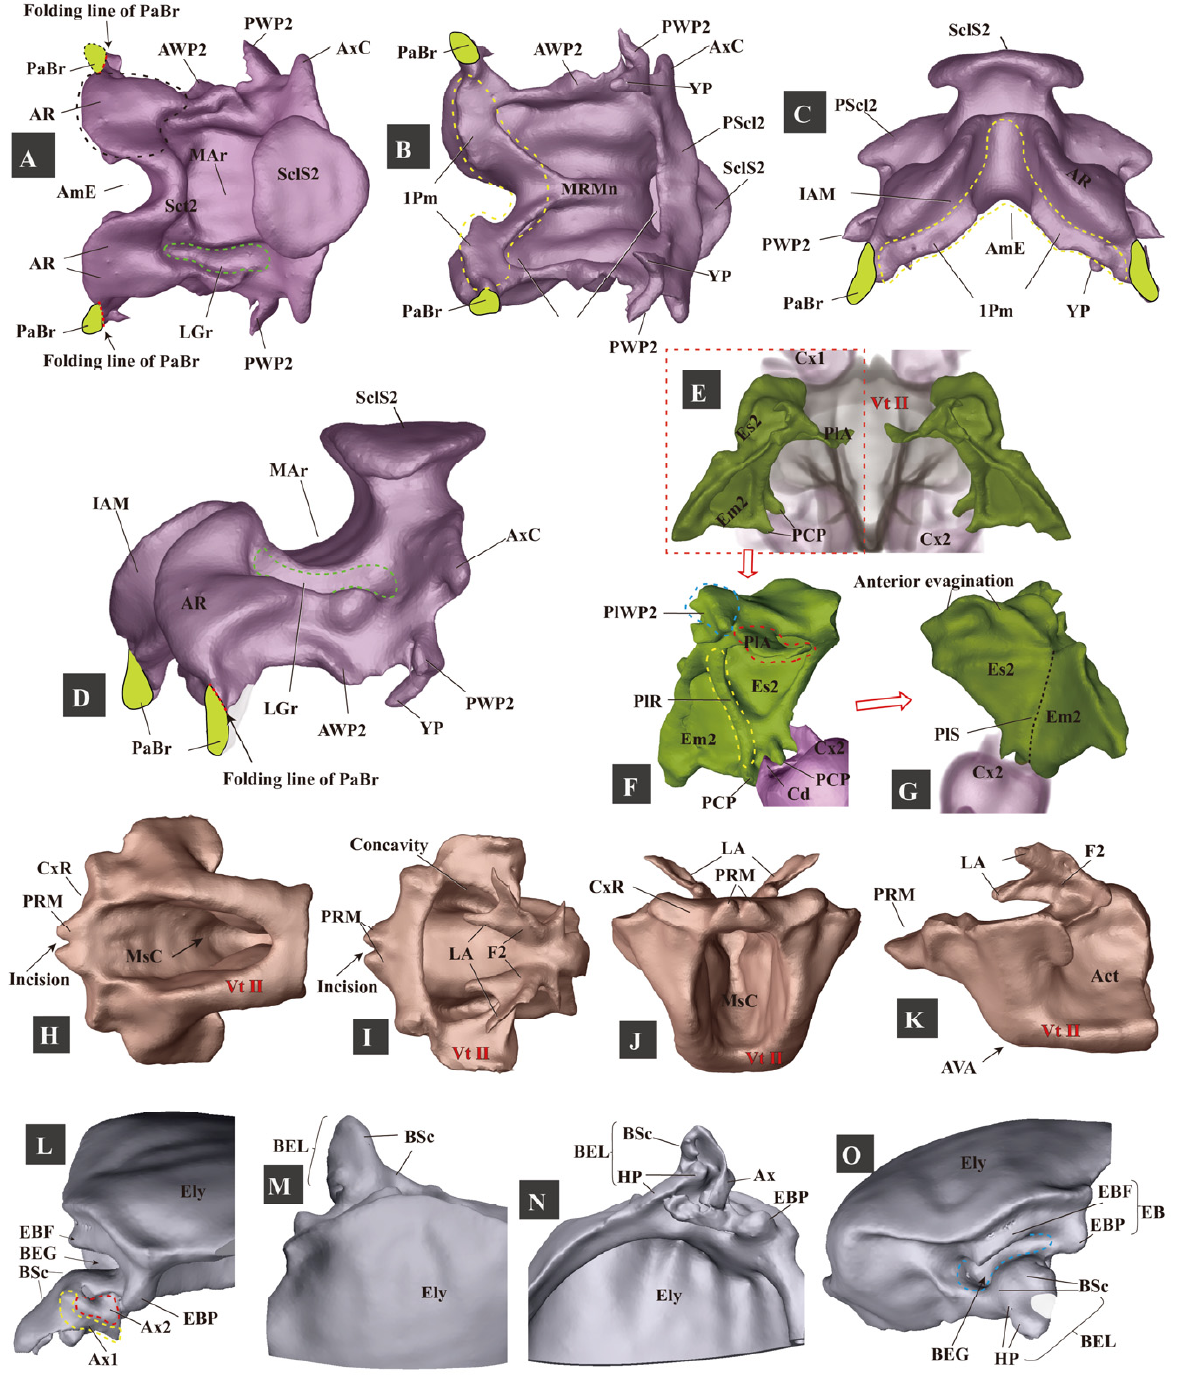
Figure 5. Three-dimensional reconstructions of the mesothoracic skeleton of Campsosternus auratus . For technical abbreviations, see Section 2 ‘Materials and Methods’. ( A – D ) dorsal, ventral, frontal, and anterolateral views of the mesonotum; PaBr is edited and shown in green color; 1Pm is marked with a yellow dashed line. ( E ) dorsal view of the mesopleura. ( F ) internal view (mesal view) of the left mesopleuron. ( G ) external view (lateral view) of the left mesopleuron. ( H – K ) ventral, dorsal, frontal, and lateral views of the mesoventrite. ( L – O ) mesal, dorsal, ventral, and frontal views of the basal part of the right